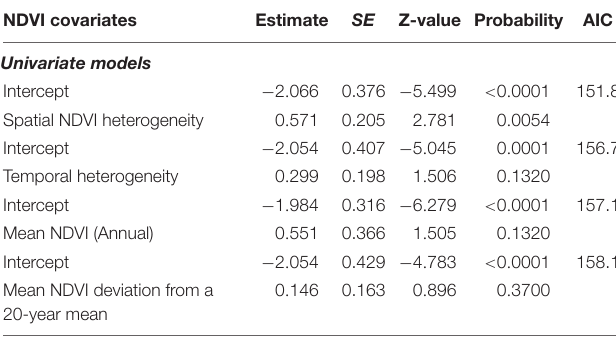
TABLE 7 | Univariate and the best multivariate NDVI models from GLMM analyses showing their influence on monthly occurrence of anthrax in focal wildlife area, Kenya.